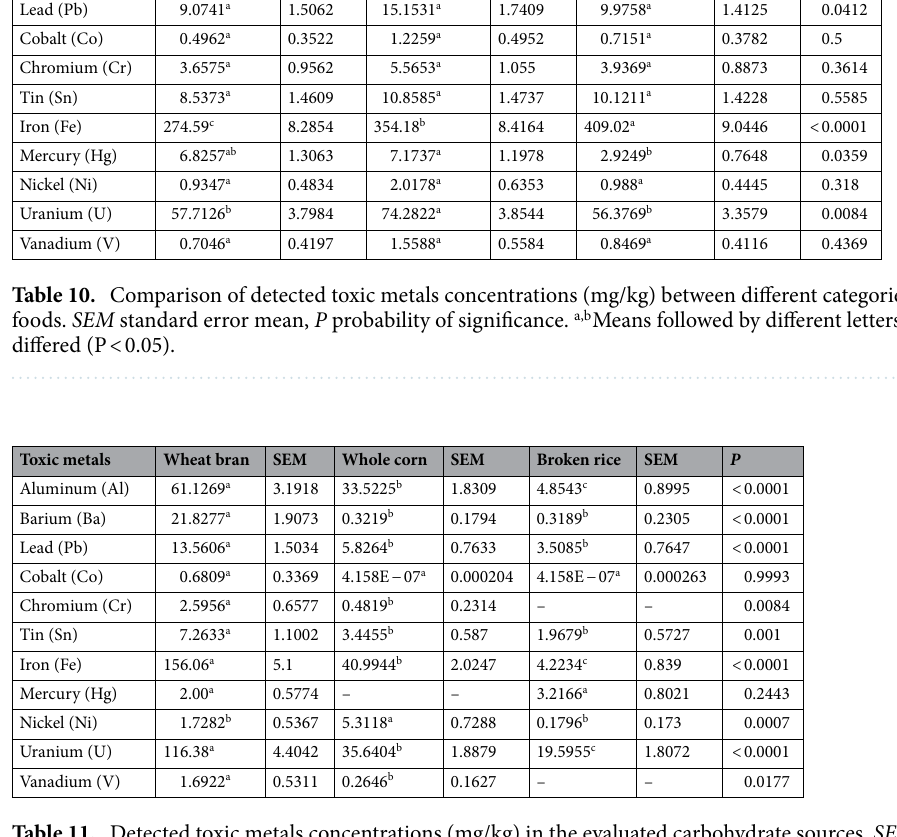
Table 11. Detected toxic metals concentrations (mg/kg) in the evaluated carbohydrate sources. SEM standard error mean, P probability of significance. a,b Means followed by different letters in the lines differed (P <